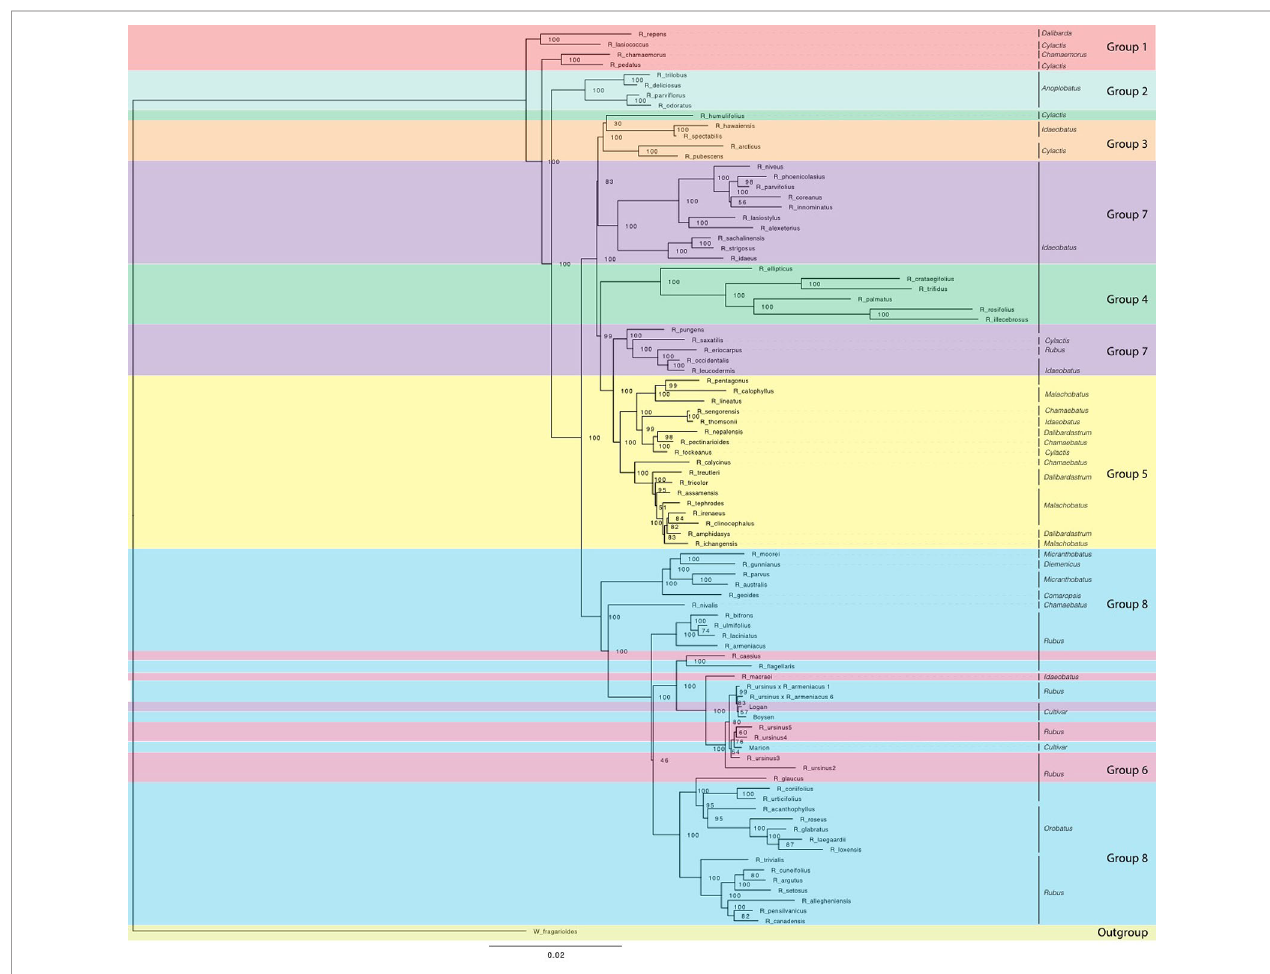
FIGURE 5 | Maximum likelihood phylogeny estimated with RAxML for chloroplast sequences from all Rubus taxa. Bootstrap values (0-100) are shown to the right of each node. Branch lengths represent relative evolutionary change. Groups are labelled with colored bands. Taxa are labelled with their subgeneric classi fi cation sensu GRIN